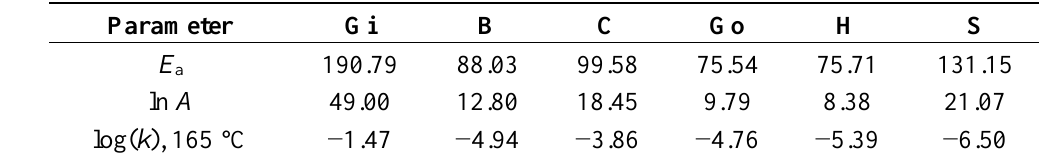
Table 5. Activation energies ( E a ; kJ·mol −1 ), pre-exponential (“frequency”) factors ( A ; s −1 ), and reaction rates at 165 °C (k; s −1 ) calculated from Arrhenius plots for mineral transformations in bauxite residue. Mineral names are abbreviated as follows: Gi—gibbsite;